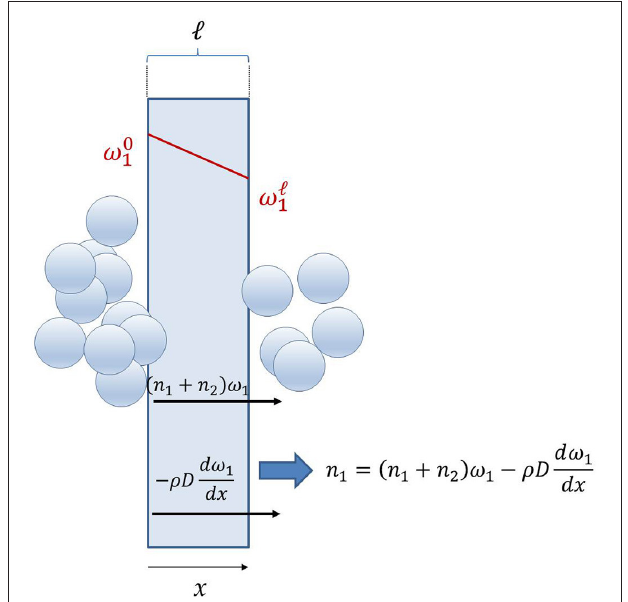
FIGURE 1 | Schematic of small molecule transport through dense polymer